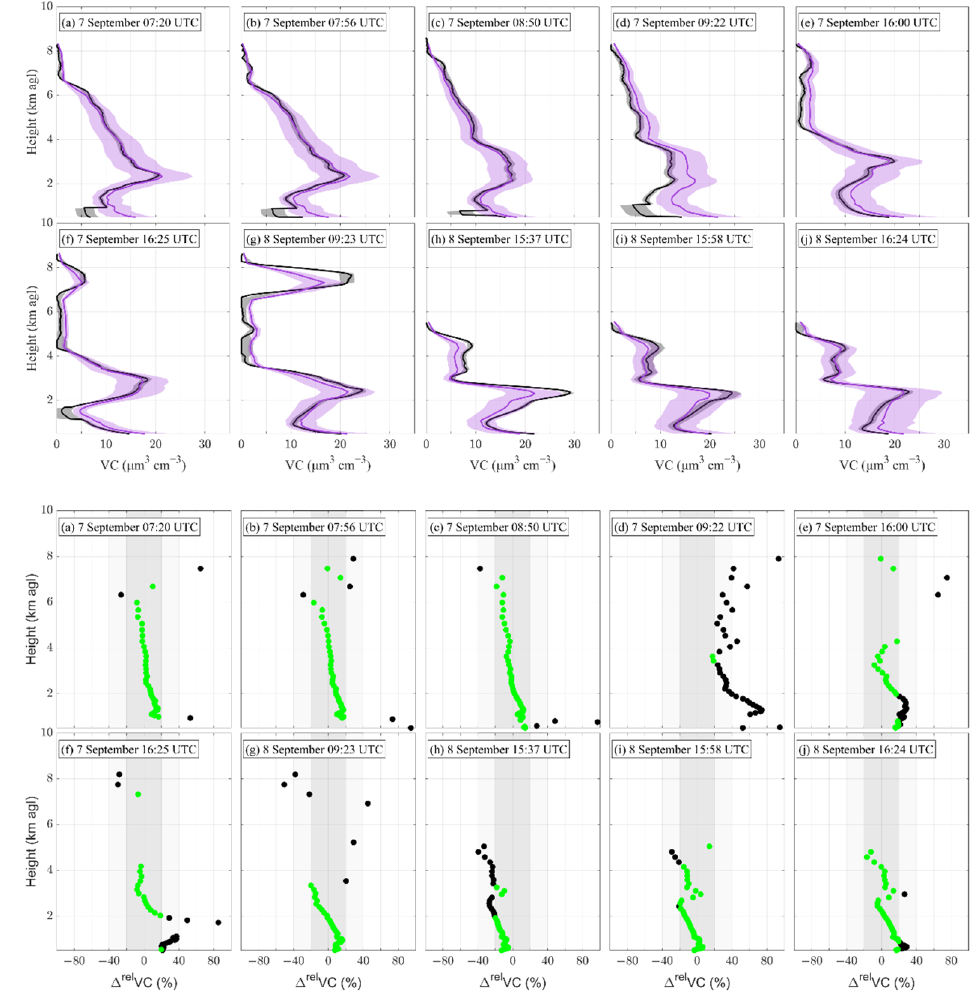
Figure 6. The same as for Figure 5, but for (top panels ( a – j )) the vertical total volume concentration VC (z) ( μ m 3 ∙ cm − 3 ), and (bottom panels) the relative differences Δ rel VC for the 10 selected BB cases. Table 4. GRASP vs. lidar ‐ derived retrieval of the total particle backscatter coefficient ( β p (z), Mm − 1 sr − 1 ) and total volume concentration (VC(z), μ m 3 cm − 3 ). Results obtained from the linear regression, i.e., m (and their error in brackets) and r, together with both MFB and χ values for those 10 selected BB cases. The profiles are averaged at the time interval of ±15 min around the sun photometer meas ‐ urements.